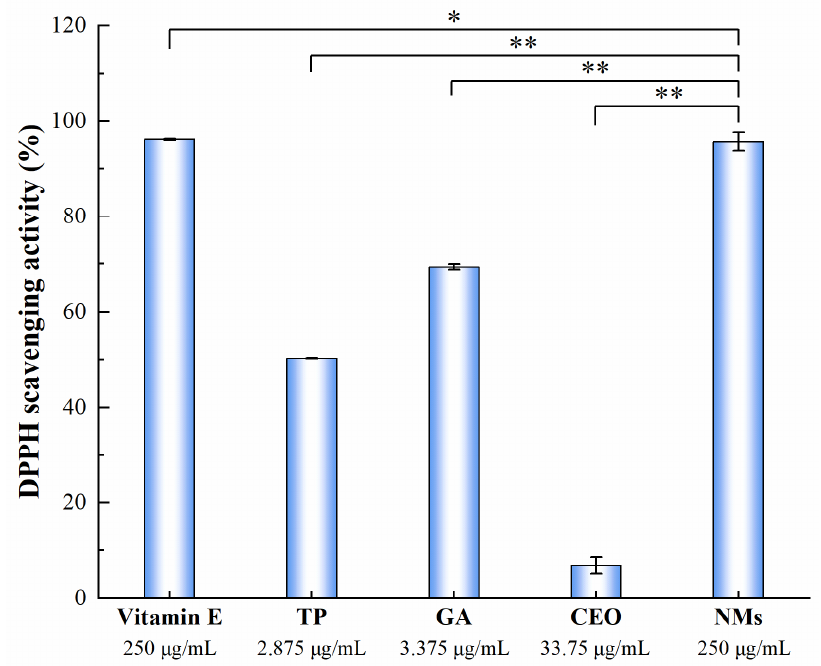
Figure 2. DPPH free-radical-scavenging capacity of NMs. Each value represents means ± SD ( n = 3). * and ** indicate statistical difference at p < 0.05 and p < 0.01 levels.